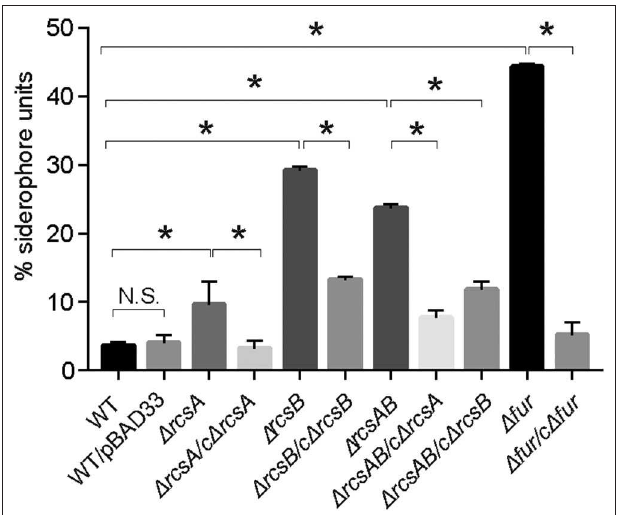
FIGURE 1 | The K. pneumoniae iron acquisition system is modulated by RcsAB and Fur. CAS assay for K. pneumoniae NTUH-K2044 wild type, wild type with empty plasmid, mutants, and complement strains were assessed as described in Material and Methods. Siderophores secreted from strains removed iron from dye complex giving rise to a reduction in blue color of the solution. Measure the absorbance (A 630 ) for loss of blue color. Results were the means of biological triplicates plus standard deviations. Bar graph showed percent siderophore units, calculated as [(Ar – As) / Ar] × 100, where Ar is the absorbance of MM9/CAS solution and As is the sample absorbance. And MM9 can be used as a blank. The percent siderophore units of WT was compared with mutants and the percent siderophore units of mutants were compared with its complement strains. P values were calculated by one-way ANOVA. * P < 0.05. Shown are the averages ± standard deviation (SD) from three independent experiments.